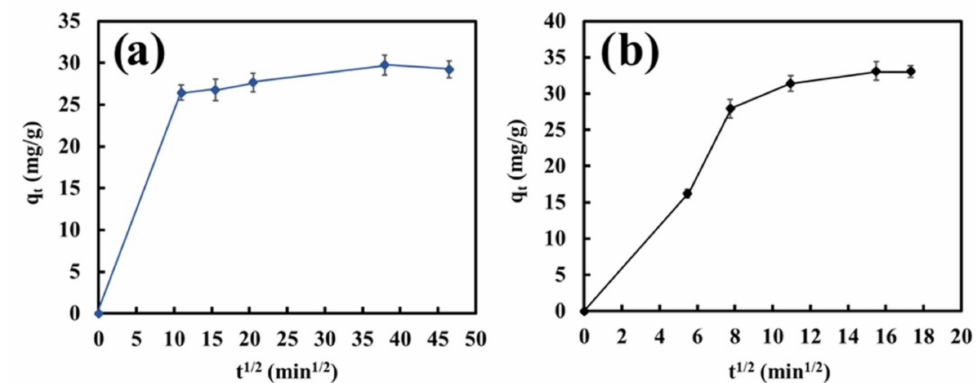
Figure 4. Description of the adsorption mechanism using the intraparticle diffusion model for ( a ) un-Ch and ( b ) Ch-FeO/TiO 2